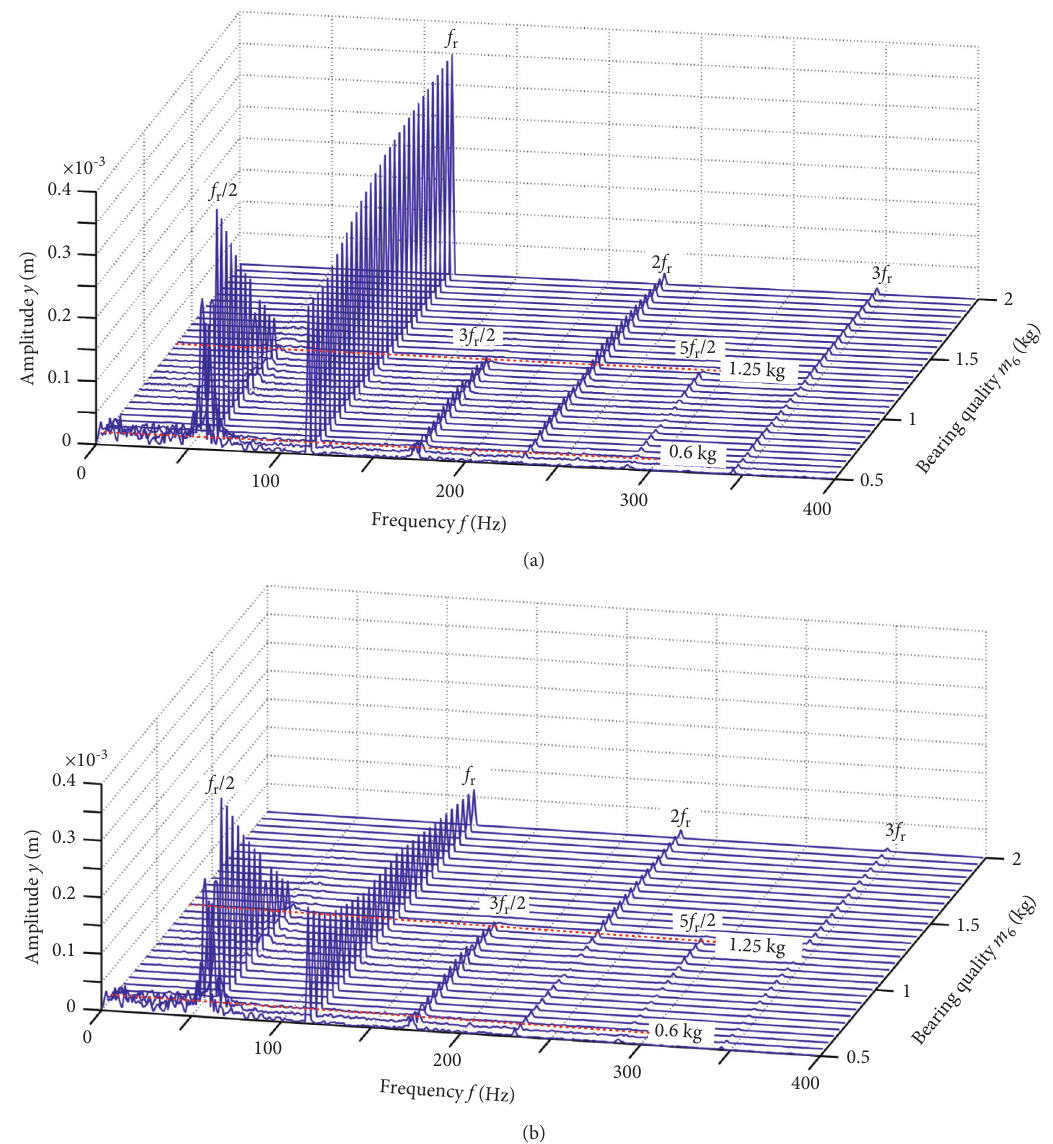
Figure 18: Spectrum cascades of the system with the change of the mass of the right bearing support. (a) Spectrum cascade of right journal. (b) Spectrum cascade of right bearing